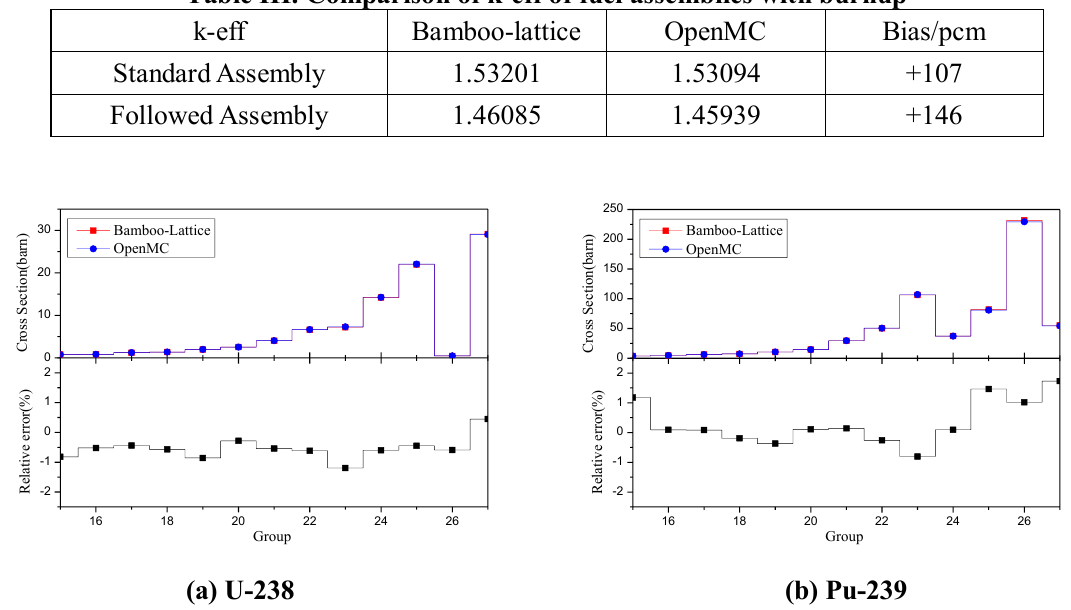
Figure 4. Comparison of the resonance absorption cross-sections for Standard Assembly with